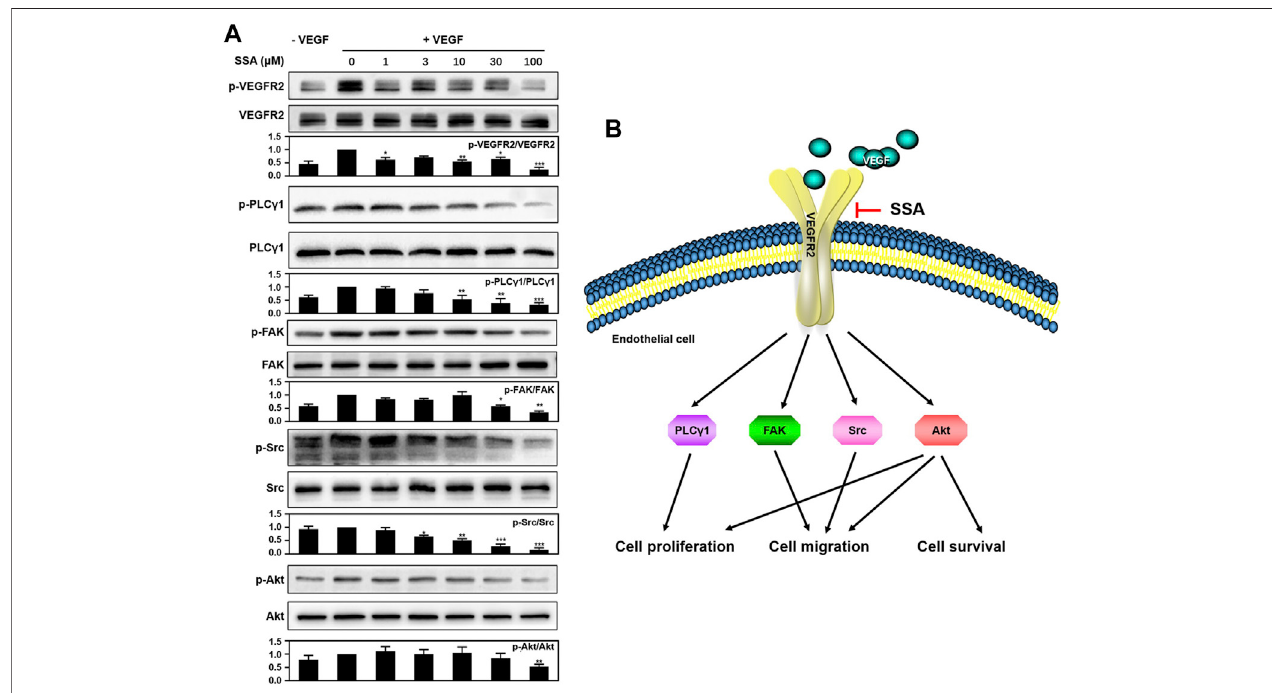
FIGURE7| SSAsuppressed thephosphorylationofVEGFR2and downstream signaling molecules in HUVECs. ( A ) SSAinhibited the activation ofVEGFR2 and its downstream signaling kinases in HUVECs. The activation of VEGFR2 and its downstream proteins, such as PLC γ 1, FAK, Src, and Akt was examined by Western blot. Thegrayscaleratioofthephosphorylatedproteintothetotalprotein wasshown.Comparisons tothecontrolgroup(celltreatedonlywithVEGF 165 )wereperformed. n (cid:1) 3. ( B ) Diagram of the SSA-mediated antiangiogenic signaling pathway. * p < 0.05, ** p < 0.01, and *** p < 0.001. n (cid:1)